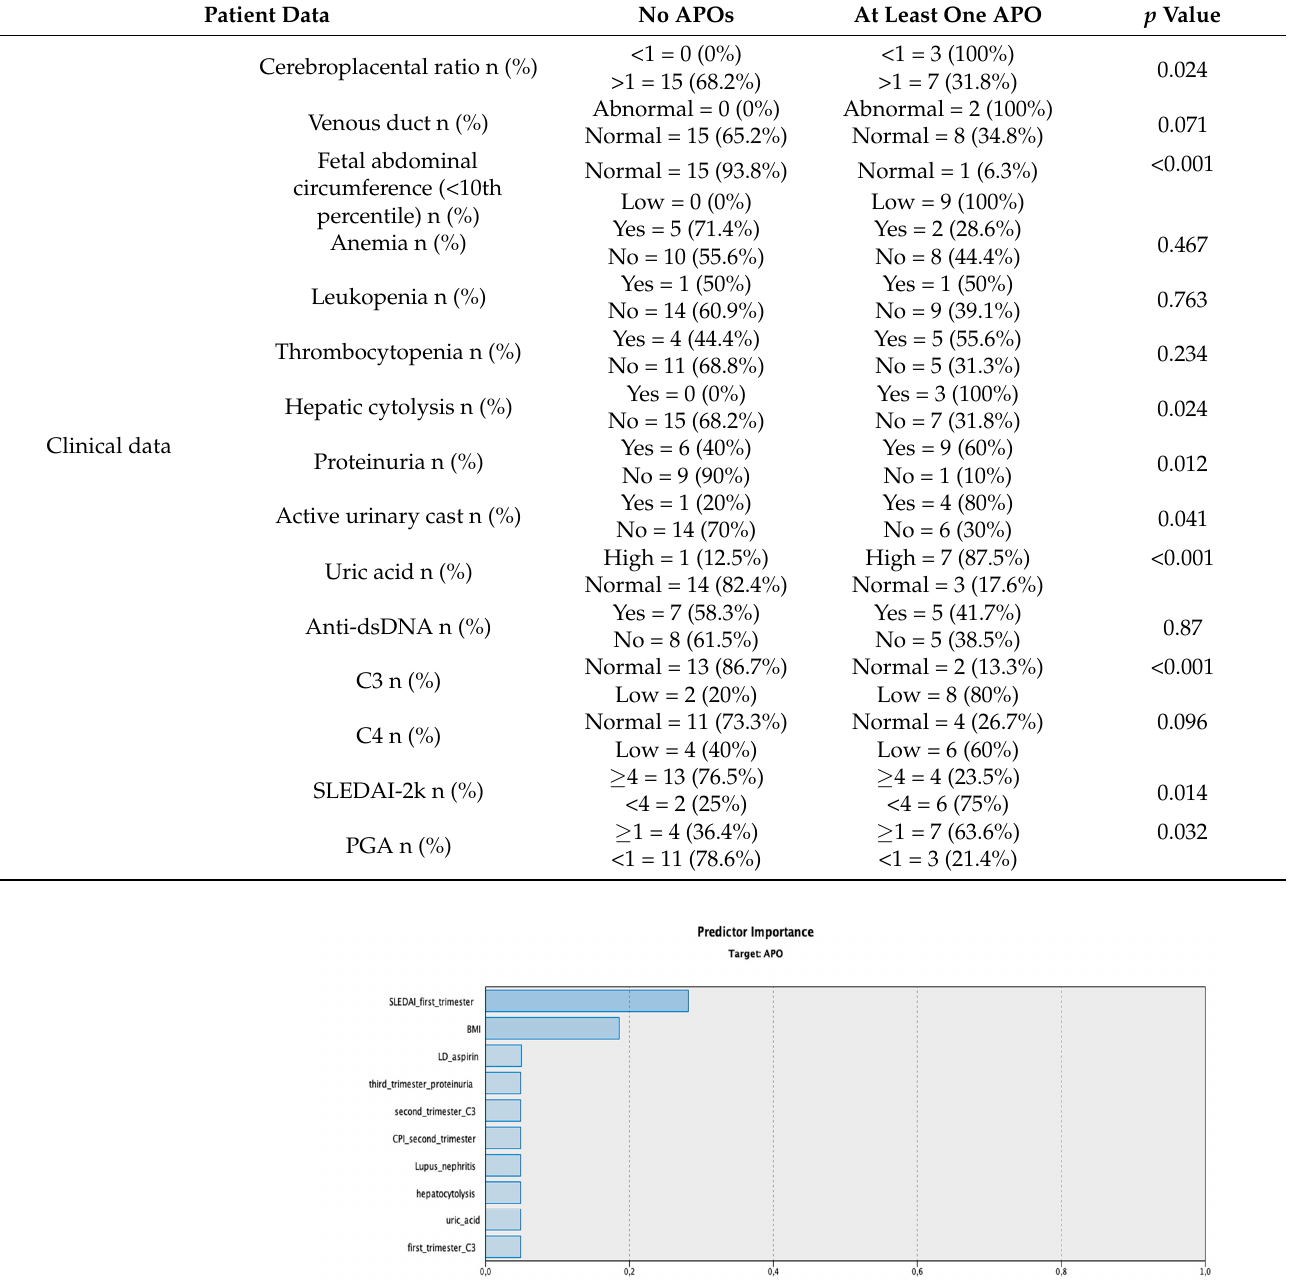
Table 3. Characteristics of pregnant SLE patients in the third trimester, and their association with adverse pregnancy outcomes (APOs).